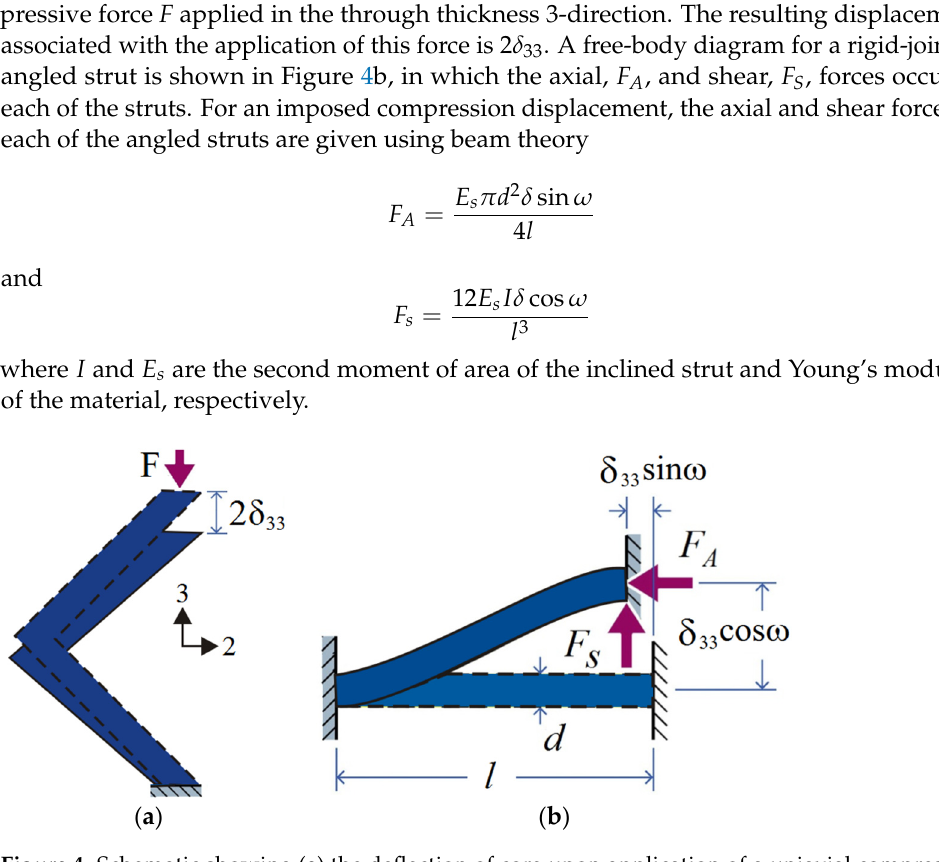
Figure 4. Schematic showing ( a ) the deflection of core upon application of a uniaxial compressive load; ( b ) the free-body diagram of a strut (half unit in Figure 2a) subjected to compression and shear. The total applied compression force on the unit cell of architecture lattice follows as